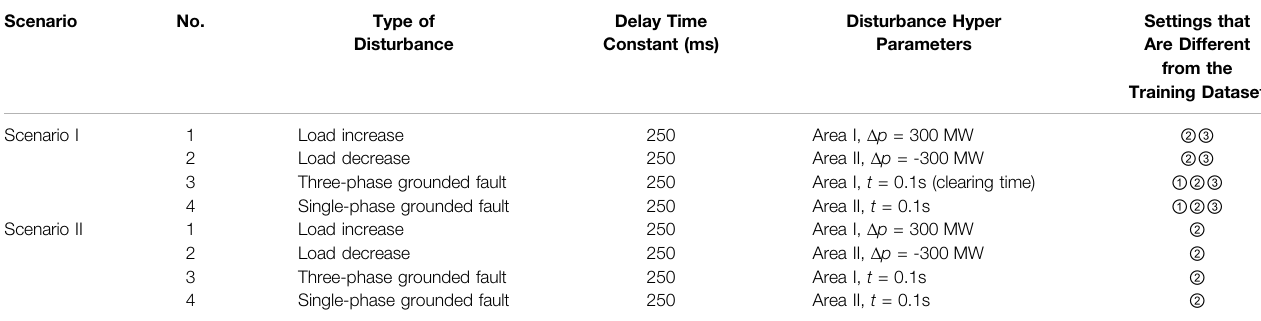
TABLE 2 | Validation